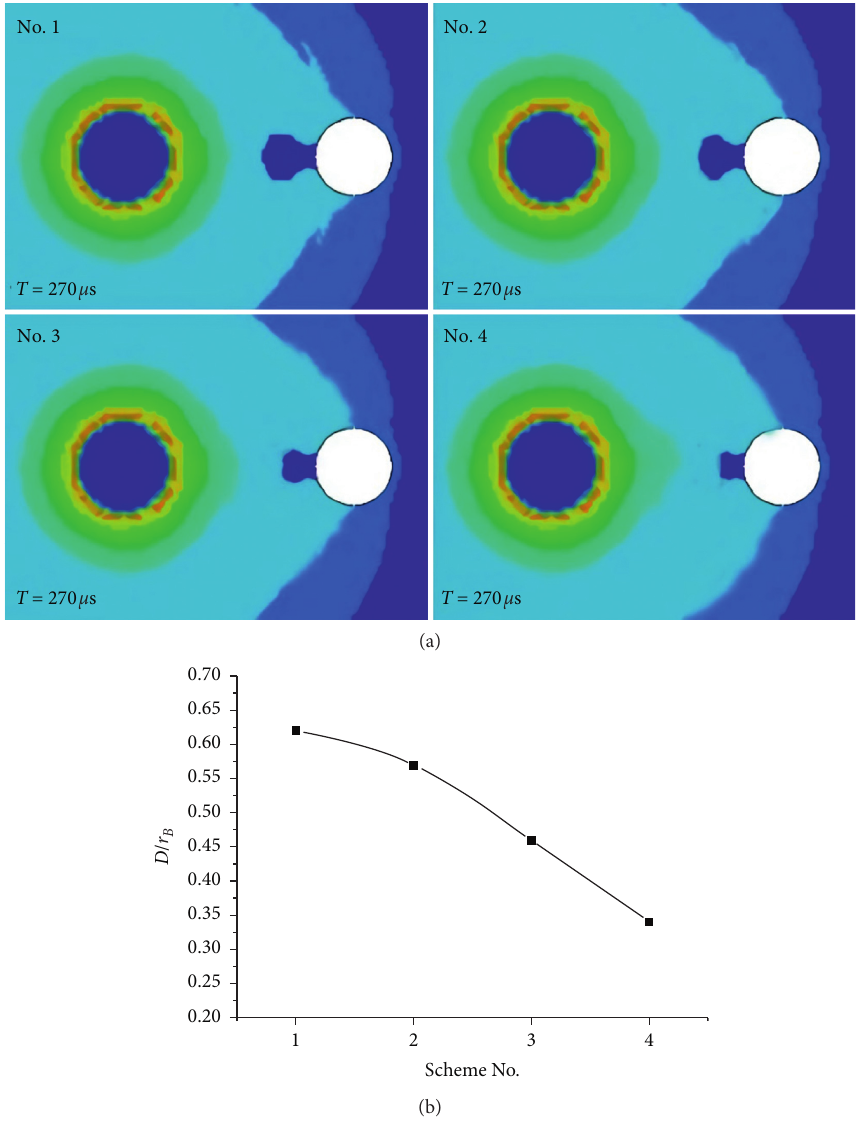
Figure 4: Cloud chart of dynamic stress distribution around the empty hole in combined stress field and curves of changes in tension zone for Scheme I. (a) Cloud chart of dynamic stress distribution in combined stress field. (b) Changes in the tension